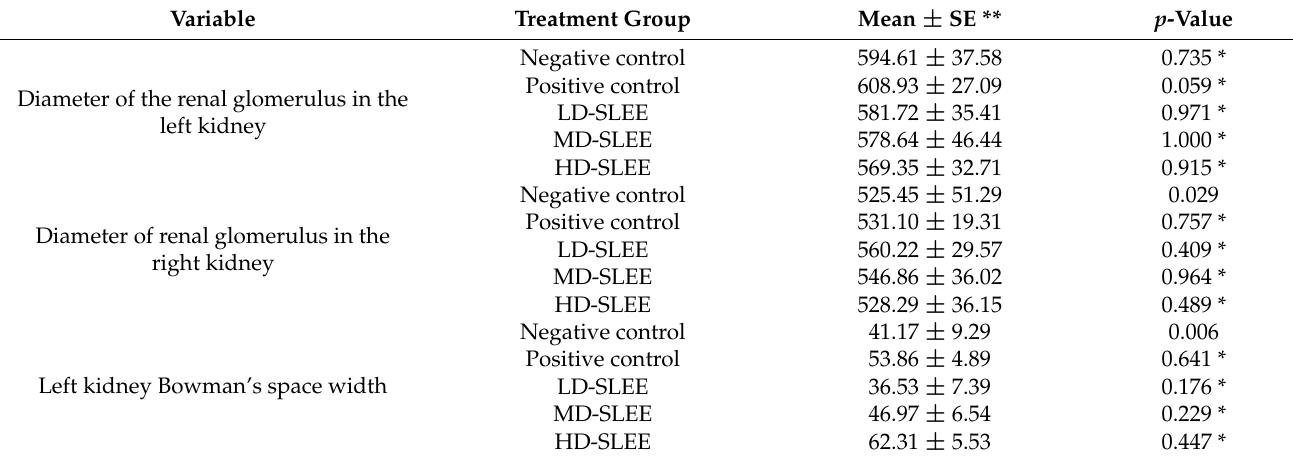
Table 3. The overall analysis of the data distribution from all variables of left and right kidneys in the treatment mice